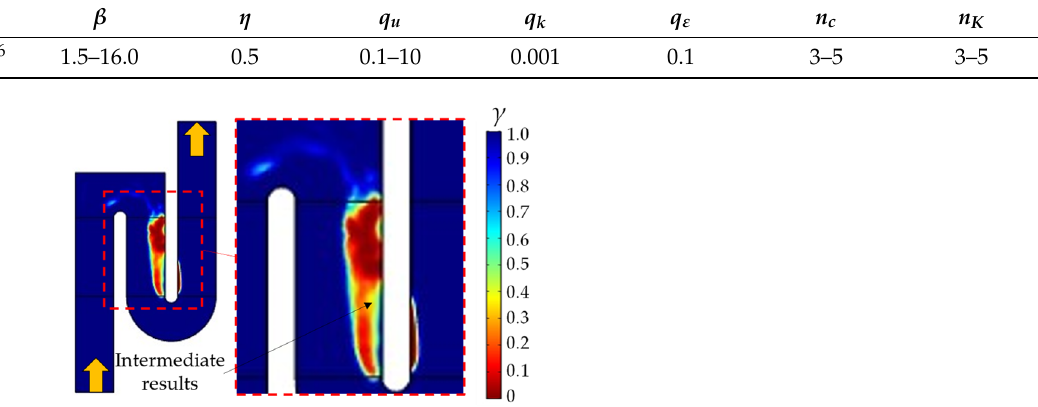
Figure 7. The optimized 2D model with intermediate results.